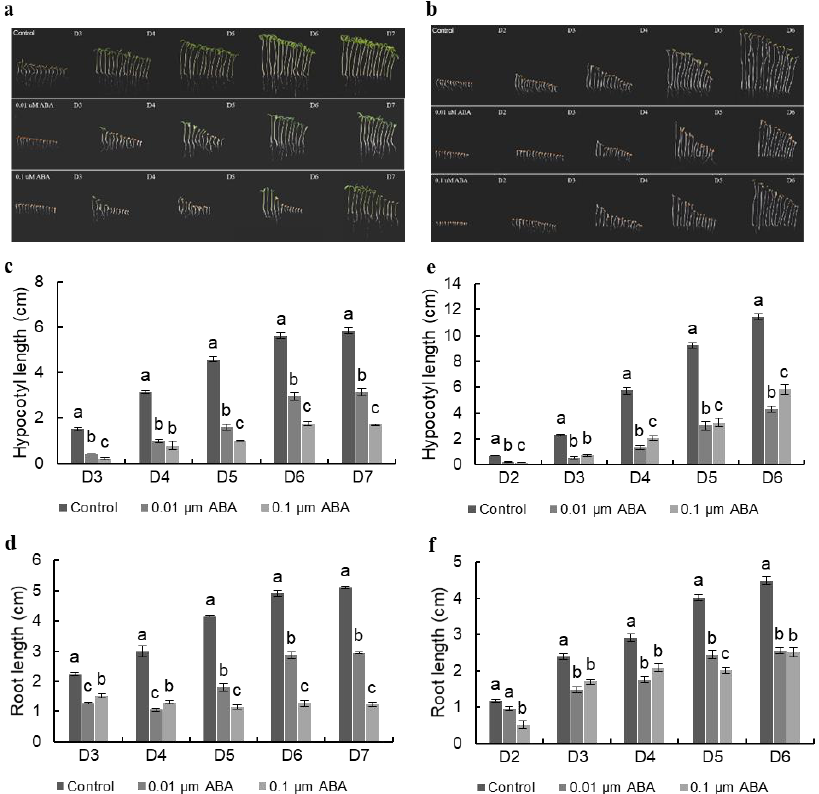
Figure 1. ABA inhibits hypocotyl and root elongation in both light-grown and dark-grown